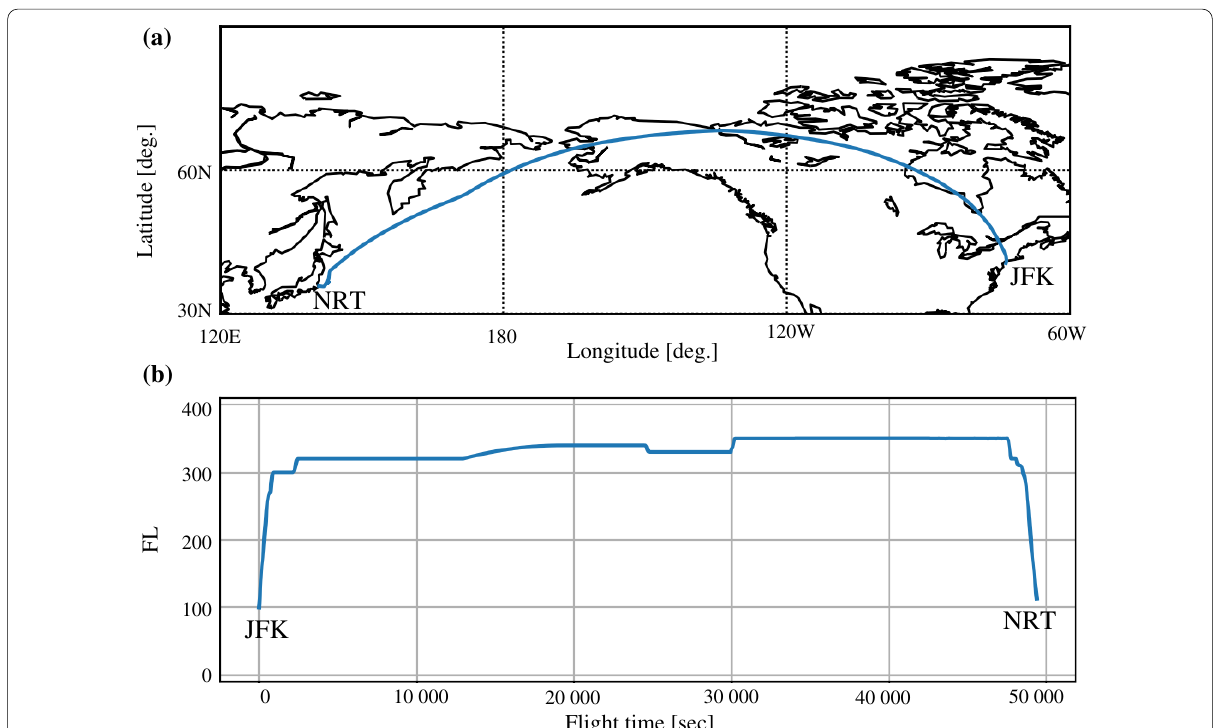
Fig. 1 a Lateral flight path from JFK to NRT (JL003) on 31 January 2020. b Flight altitudes in the unit of 100 feet (FL) from JFK to NRT (JL003) on 31 January